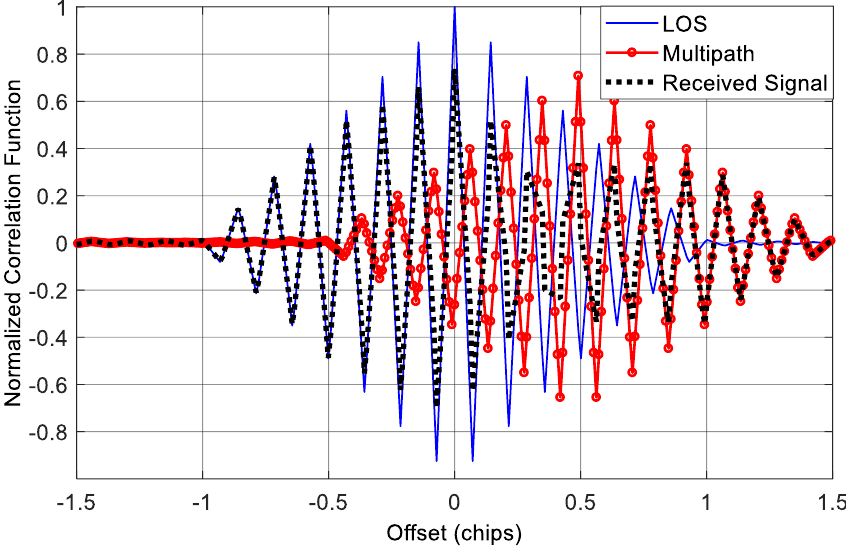
Figure 14. Correlation function of BOC(14,2) signal in the presence of single multipath component.